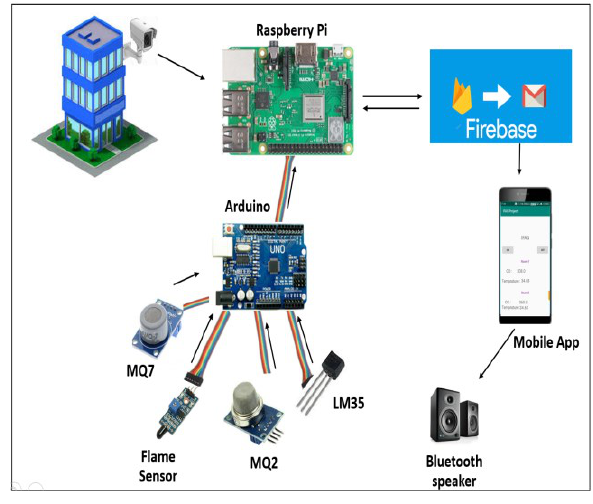
Figure 3. IFD connected with different